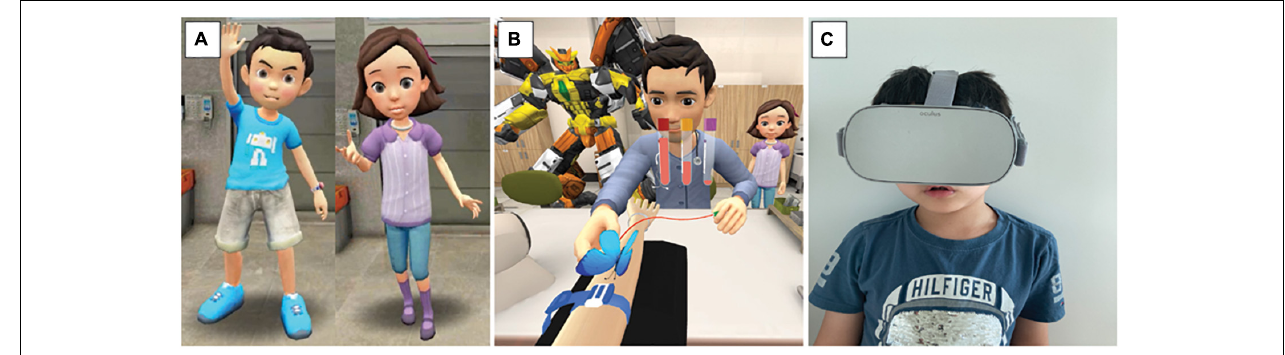
FIGURE 1 | Virtual reality education system. (A) Children select Chatan (left) or Mona (right) as a main character; (B) and experience venipuncture procedure in a 360 ◦ and 3-dimensional virtual phlebotomy unit; (C) with a head-mounted virtual reality